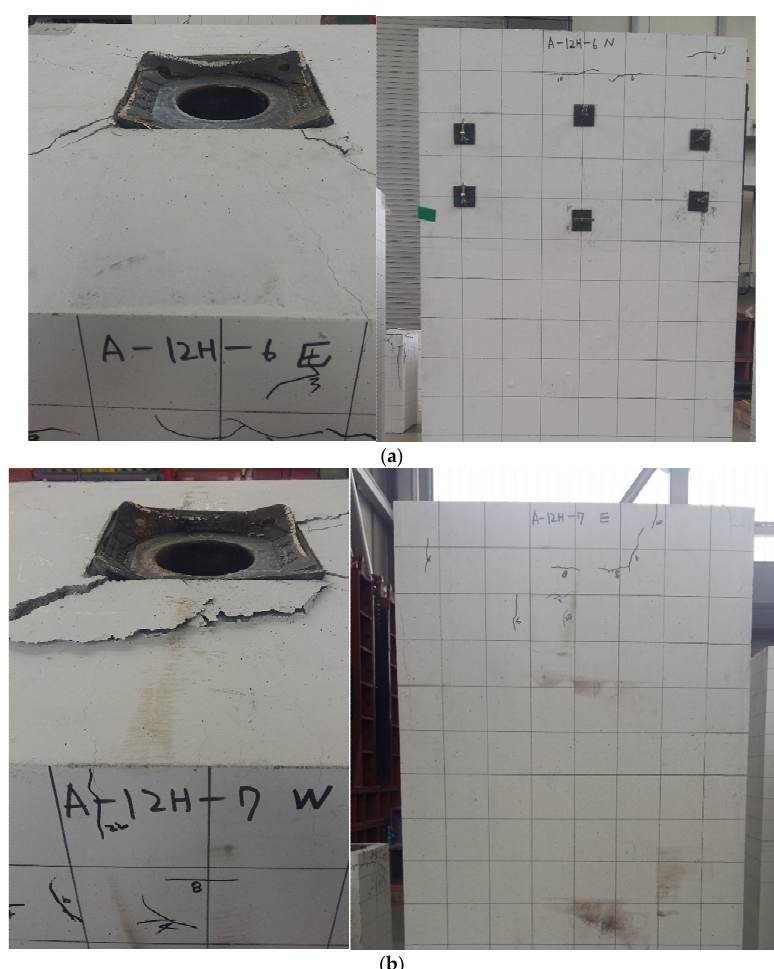
Figure 8. Fracture modes of group 2 specimens: ( a ) A12H-6; ( b ) A12H-7.